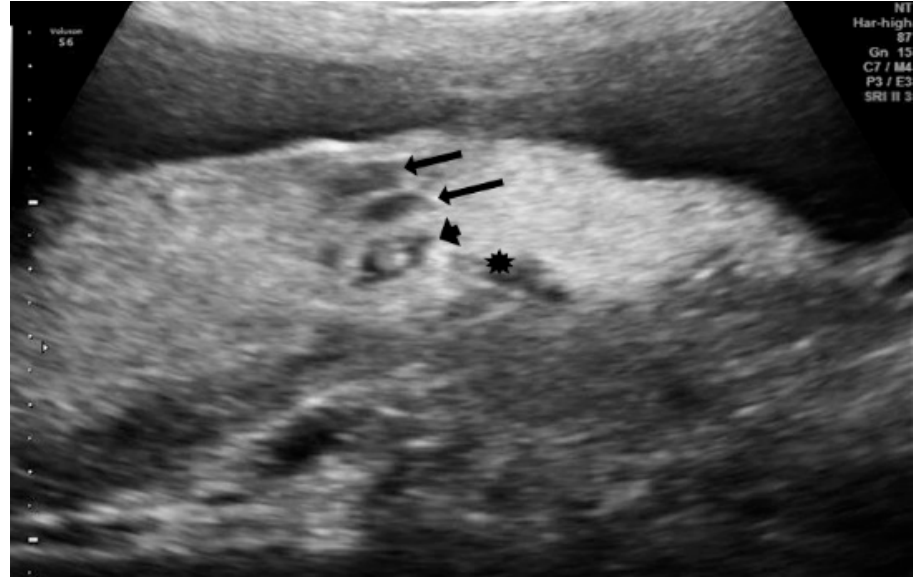
Figure 1. Ultrasonographic placental image: placental lakes (arrow), fibrin deposits, signs of throm- bosis (arrowhead), and subplacental blood pools are observed.